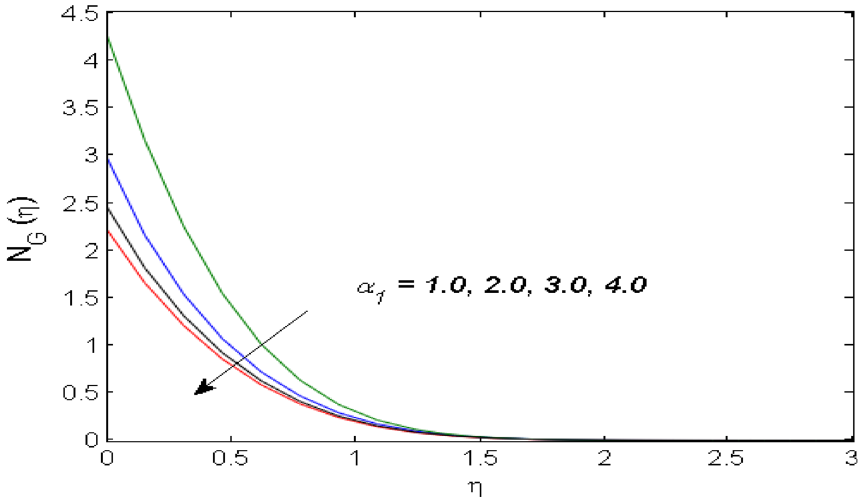
Figure 15. N G (η) versus varied estimates of α 1 .